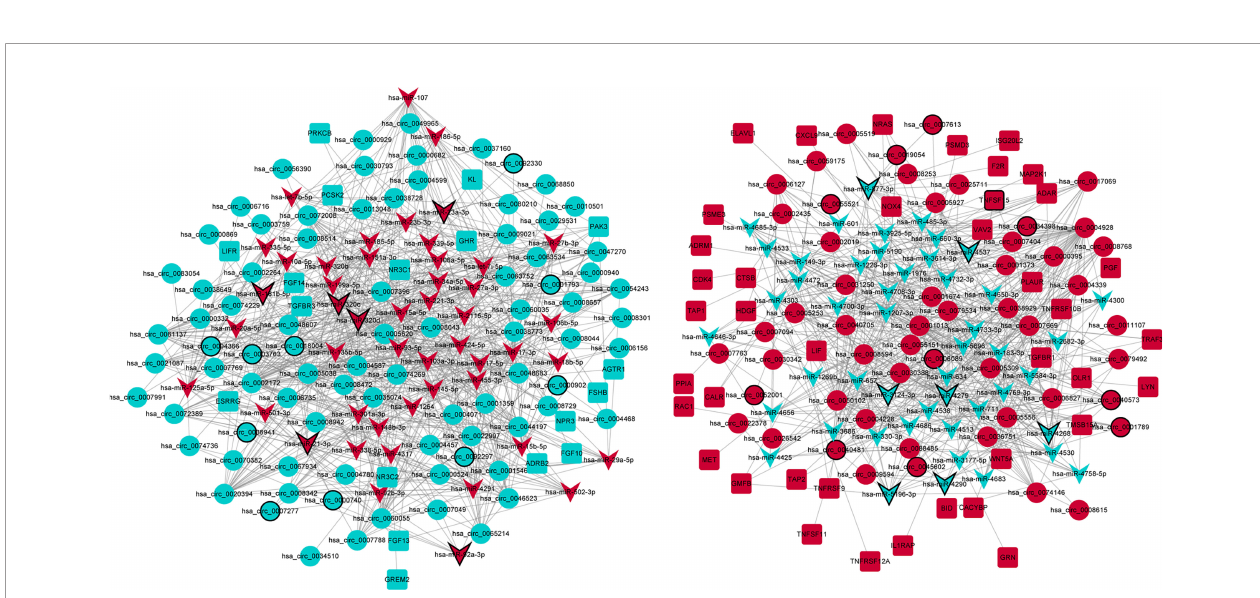
FIGURE 3 | The ceRNA (circRNA – miRNA – immune-related mRNA) regulatory network in GC. Circle, V shape, and rectangle represent differentially expressed circRNA, miRNA, and mRNA, respectively. Red and green represent upregulation and downregulation, respectively. The black border represents the top 10 up/ downregulated